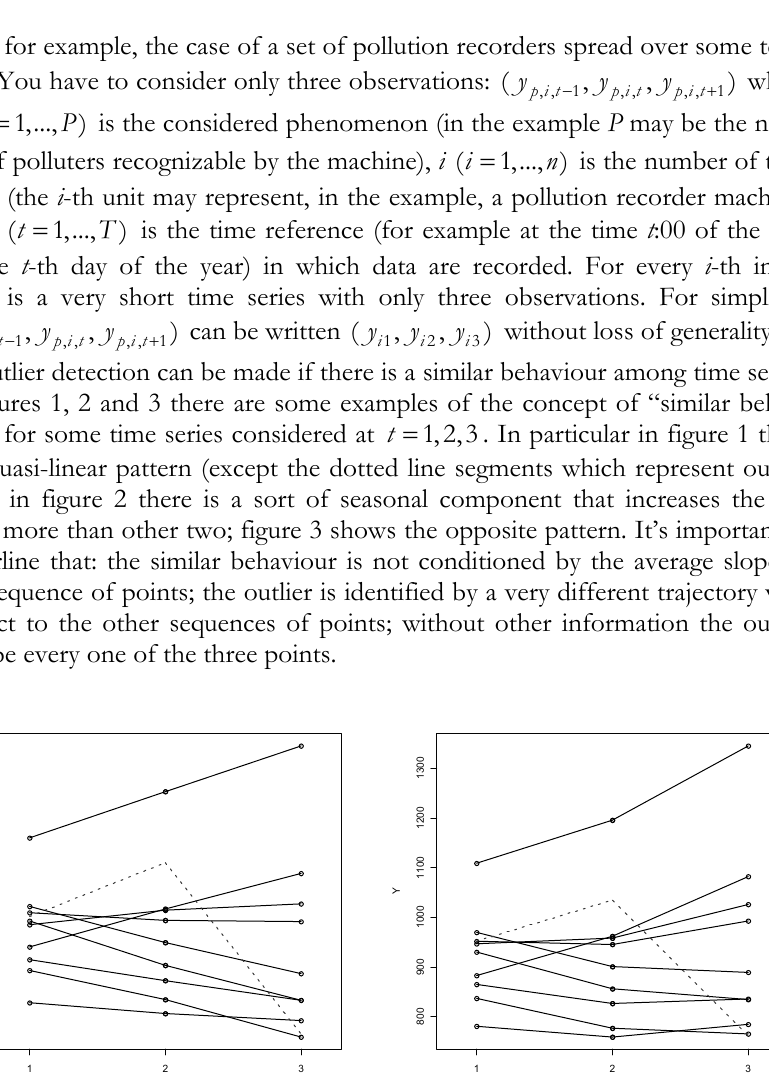
Figure 2 – Examples of positive seasonal component at t